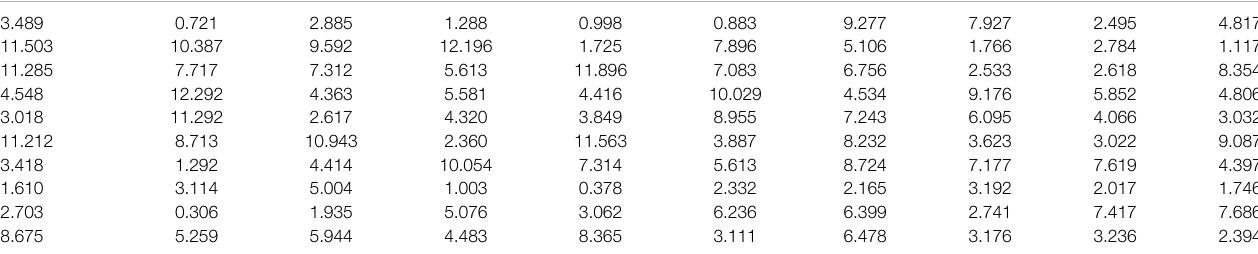
TABLE 2 | The amount of information on the satisfaction of logistics service provider to the users.